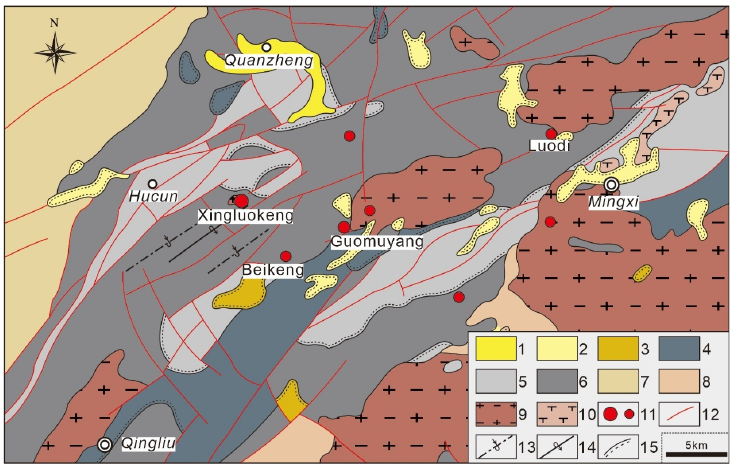
Figure 2. Regional geological map of the Xingluokeng W-Mo ore field showing W deposits in the area (modified after [46]). 1 = quaternary; 2 = tertiary; 3 = cretaceous; 4 = Jurassic System; 5 = Upper Devonian–Permian; 6 = Upper Sinian-Lower Cambrian; 7 = Caledonian gneissic biotite monzogranite; 8 = Indosinian gneissic biotite monzogranite; 9 = Yanshanian biotite granite; 10 = Yanshanian syenite; 11 = W deposit and mineralization point; 12 = fault; 13 = axis of overturned synclinal; 14 = axis of overturned anticline; and 15 = unconformity boundary.